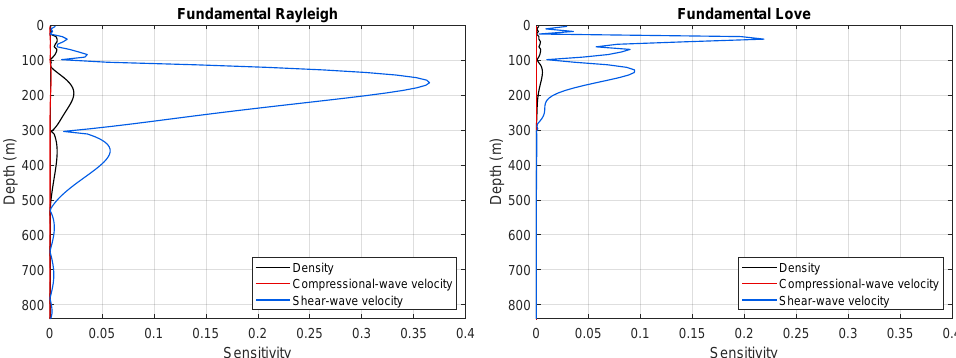
Figure 5. Absolute value of the sensitivity kernels for fundamental Rayleigh and Love waves for density, compressional-wave velocity and shear-wave velocity at a frequency of 1 Hz.